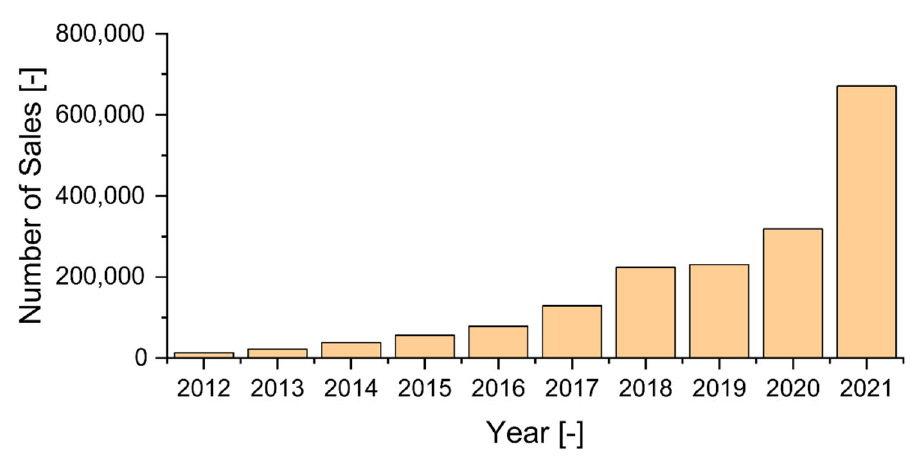
Figure 1. Number of new registrations of electric cars worldwide from 2012 to 2021 [2].